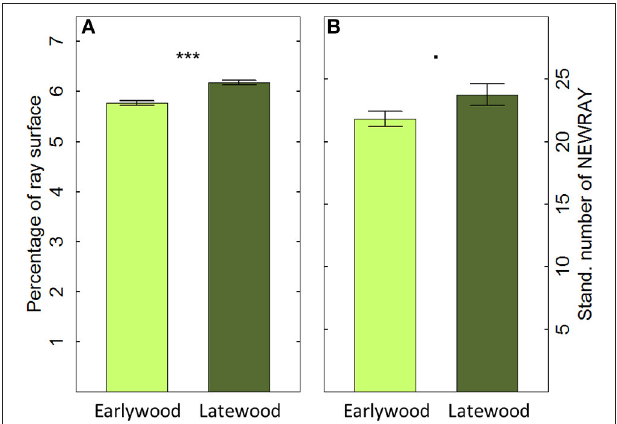
FIGURE 4 | Percentage of ray surface (PERPAR, A) and number of initiating rays (NEWRAY, B) in early- and latewood based on cross-sectional measurement of 20 tree rings in 40 mature Scots pine trees (mean ± 1 se; n = 800 ). NEWRAY is expressed as counts per width unit (mm) to account for different widths of early- or latewood (Stand. number of NEWRAY). *** P ≤ 0.001 ; · P ≤ 0.1